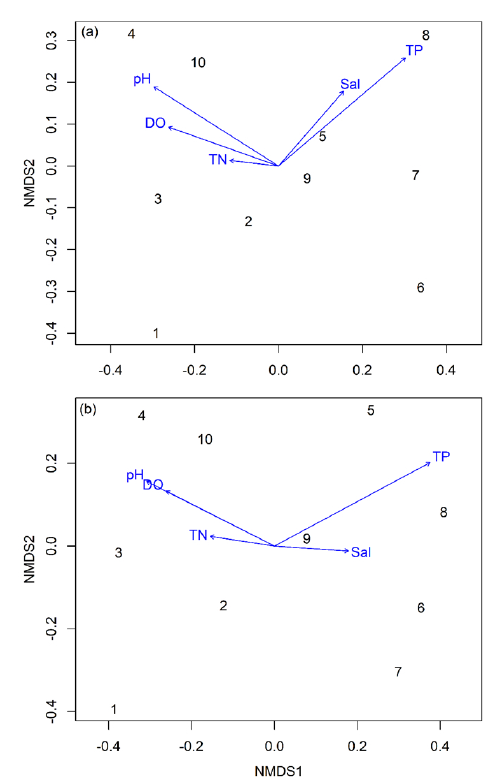
Figure 5. NMDS of benthic diatom communities using (a) presence-absence data and (b) abundance data. The numbers represent the 10 sampled streams; DO = dissolved oxygen; TN = total nitrogen; TP = total phosphorus; pH = potential of hydrogen; Sal =